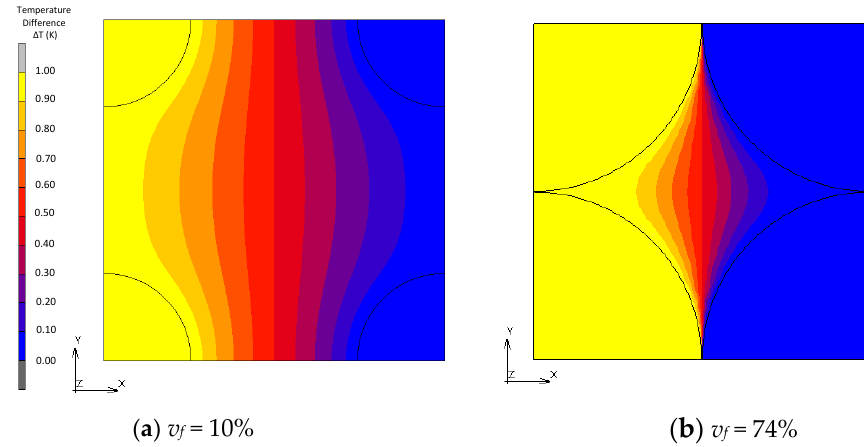
Figure 11. Temperature distribution of transformed FCC models.